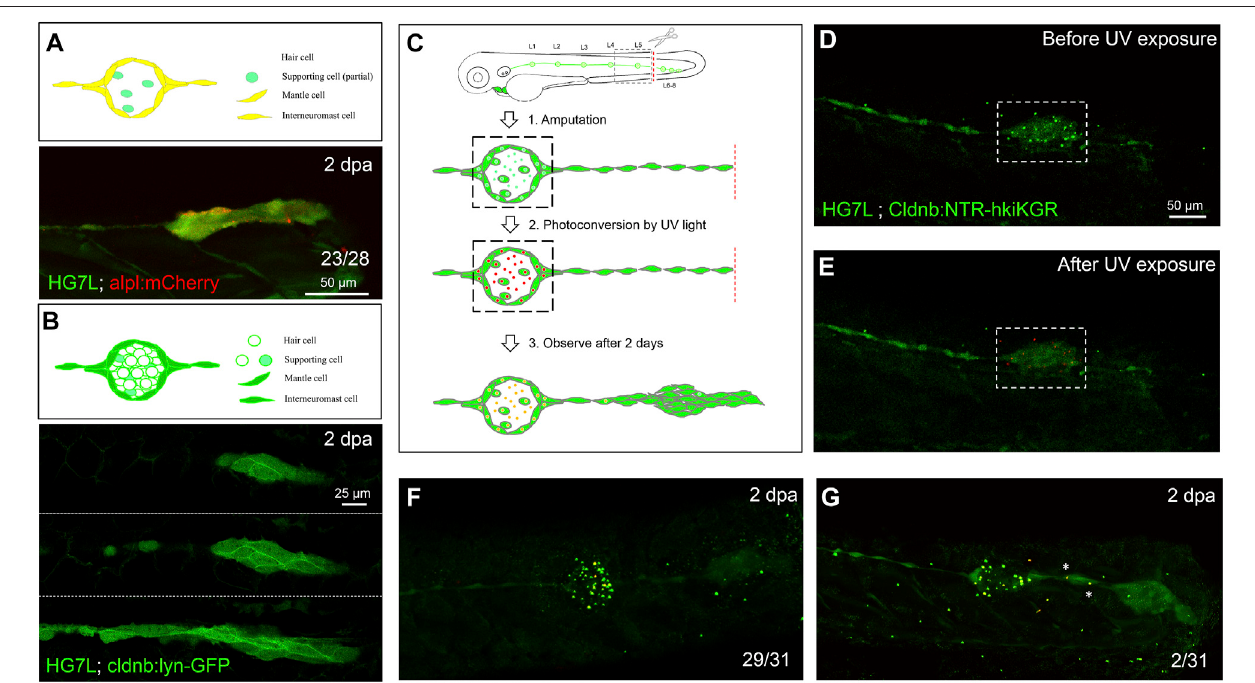
FIGURE 2 | Interneuromast cells are the origin of clustering cells post – fi n amputation. We performed fi n amputation on double transgenic larvae from the cross of the Et(HG7L) withthe Tg( − 4.7alpl:mCherry) (alpl:mCherry)or Tg( − 8.0cldnb:lyn-GFP) (cldnb:lynGFP)totracktheoriginofprogenitorcellsfortheregeneratingclusterpost fi namputation at2 days afteramputation (2 dpa). (A) Theregeneratingclusterof fi n-amputatedlarvaeof Et(HG7L)XTg( − 4.7alpl:mCherry) linewasexaminedat GFPor mCherry channel and photographed under confocal microscopy. A representative superimposed image from both channels is shown. The regenerating cluster image contains mostly yellow signals. As illustrated in the cartoon, the clustering cells could be originated from both interneuromast cells (INCs) and mantle cells (MCs). (B) Theregeneratingclusterof fi n-amputatedlarvaeof Et(HG7L) X Tg( − 8.0cldnb:lyn-GFP) wasexaminedattheGFPchanneltoscantheZ-axis.Imagesatthreedifferent z positions clearly show the existence of both membrane and cytosol green fl uorescence. As illustrated in the cartoon, the signals could be originated from INCs, MCs, and supporting cells. (C) A series of cartoons shows utilizing a Tg( − 8.0cldnb:NTR-hKikGR;myl7:EGFP) transgenic line, which expresses nitroreductase (NTR) and hKikGR fusion protein, to further discern whether the clustering cells are from INCs or cells inside a neuromast. To label the lateral line, we used larvae from the cross of Et(HG7L) (green)and Tg( − 8.0cldnb:NTR-hKikGR;myl7:EGFP) (green dots),examined andphotographed at theGFPchannel before (D) and afterUVexposure (E) .After UV exposure, the green hKikGR dots were converted to red in all cell types, including MCs within distal neuromast right after fi n amputation. (F) At 2 dpa, labeled cells generatednewgreenhKikGRproteins. Asshown in (F) ,theminglingofgreenandred signalsbecomesyellow.Thelabeled cellswithintheneuromastsrarely escapedin most treated larvae (29/31). However, we observed that a few larvae (2/31) showed yellow signals in the neighboring of INCs (white asterisks), as shown in (G)